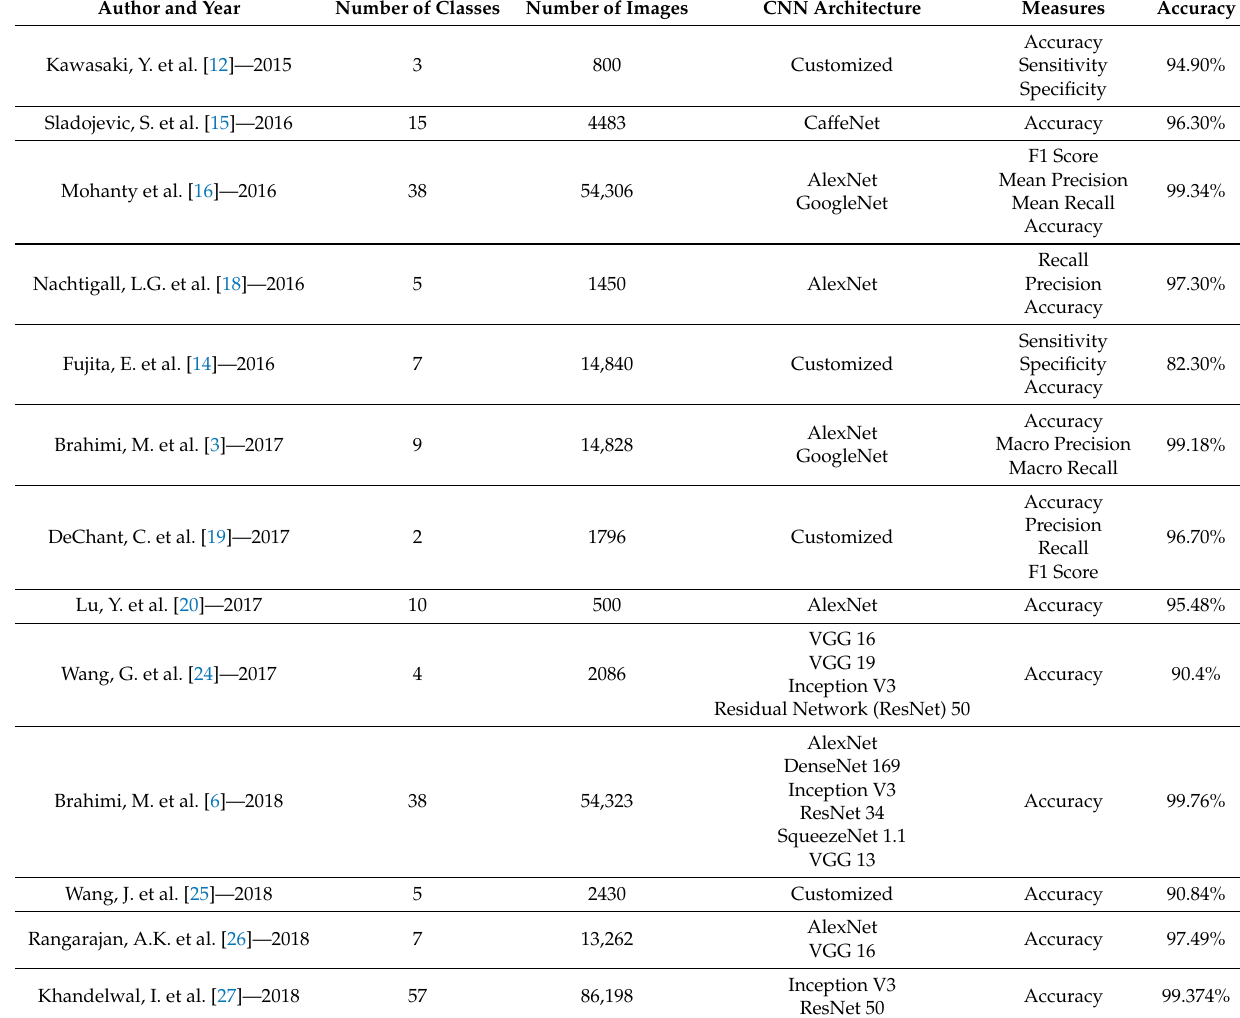
Table 1. Summary of techniques and comparison between studies for classification plant